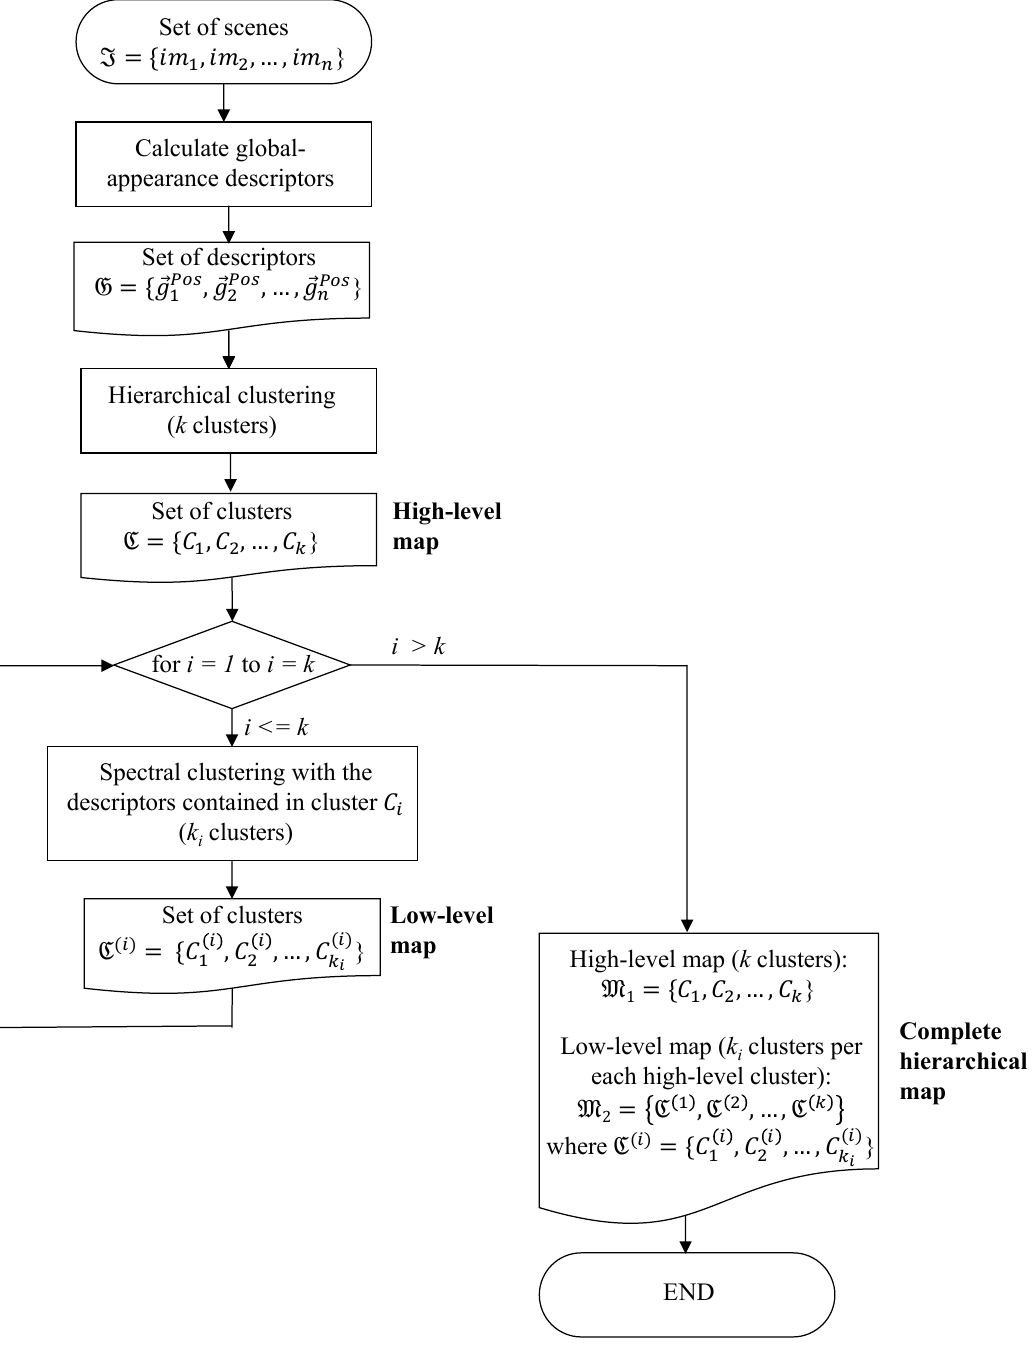
Figure 3. Block diagram of the complete proposed framework to build a hierarchical map from a set of